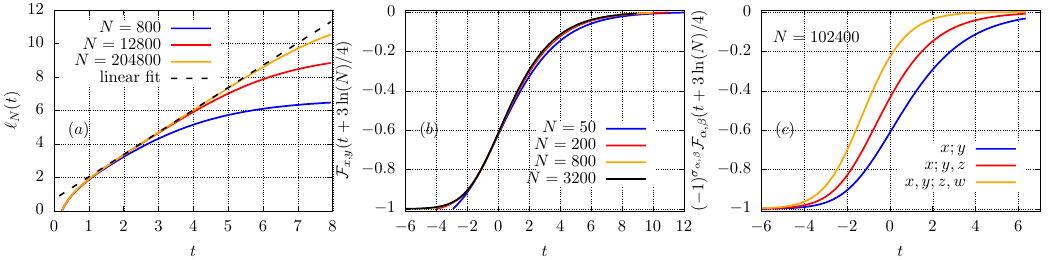
Figure 6 . Sub(cid:12)gure ( a ): rescaled logarithmic OTOC ‘ N ( t ) [de(cid:12)ned in eq. (4.5)]. Solid lines correspond to increasing values of N (from bottom to top), while the dashed black line is the linear ansatz y ( t ) = 4 t + ln(2). Sub(cid:12)gure ( b ): data collapse using the shift (4.7) for the OTOCs ( t ) 3 F x;y (with x = y ). Sub(cid:12)gure ( c ): data collapse for di(cid:11)erent OTOCs. The curves correspond (from 6 bottom to top) to the OTOCs in eq. (4.1), (4.8) and (4.9) respectively. In order to compare the three curves, we have multiplied by the global phase ( 1) (cid:27) (cid:11);(cid:12) , which is 1 for ( (cid:11) ; (cid:12) ) = ( x; y ; z; w ) F (cid:11);(cid:12) (cid:0) (cid:0) and 1